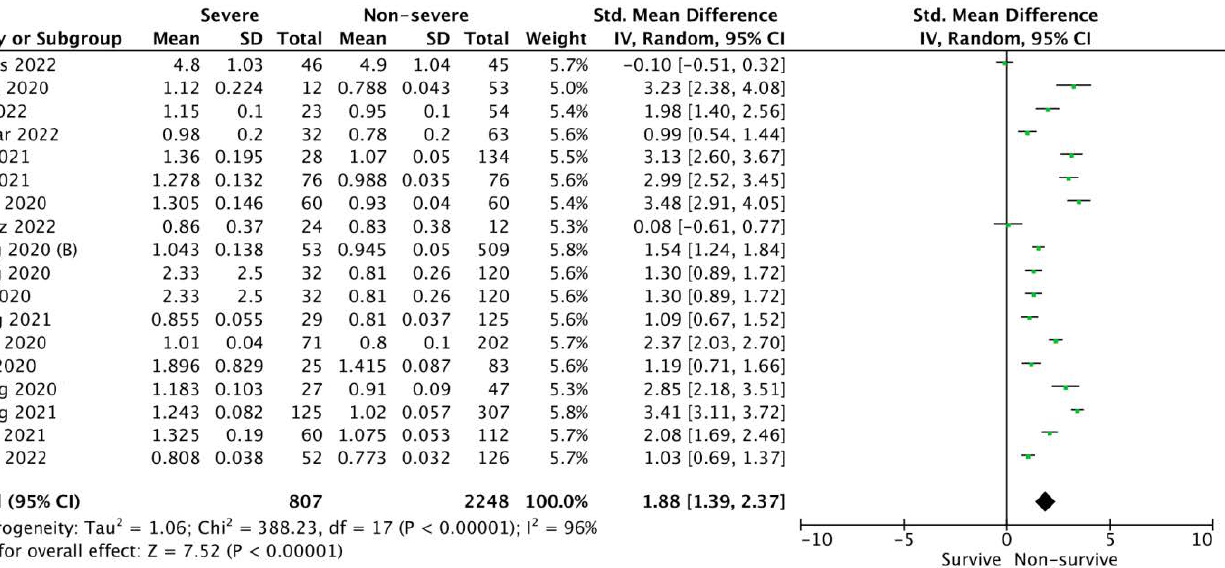
Figure 4. Forest plot of Cystatin C levels among Patients with COVID-19 with and without acute kidney injury (AKI). The center of each square represents the standard mean differences for indi- vidual trials, and the corresponding horizontal line stands for a 95% confidence interval. The dia- monds represent pooled results. Legend: AKI: acute kidney injury; CI: confidence interval; SD: standard deviation.